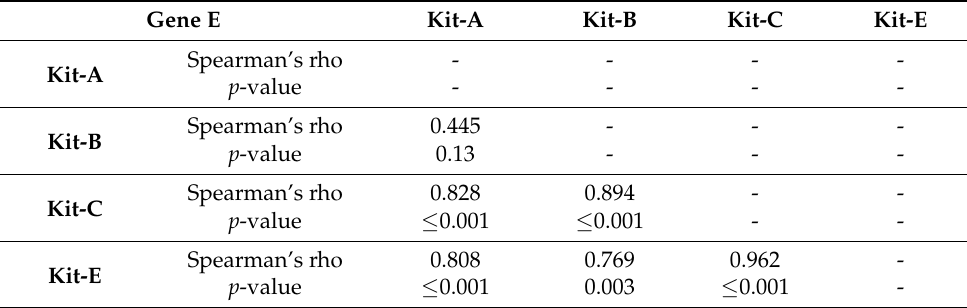
Table 6. Correlation matrix of three commercial kits targeting gene E and RdRP